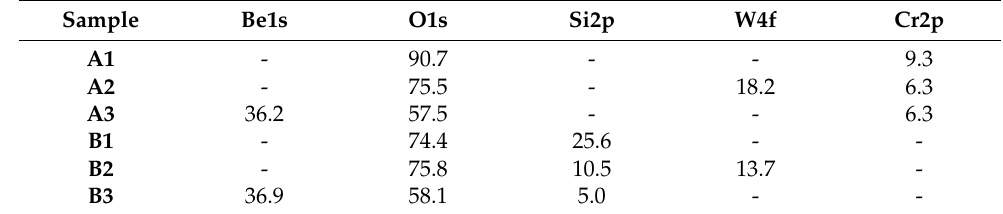
Table 3. XPS determined element relative concentrations (at.%).